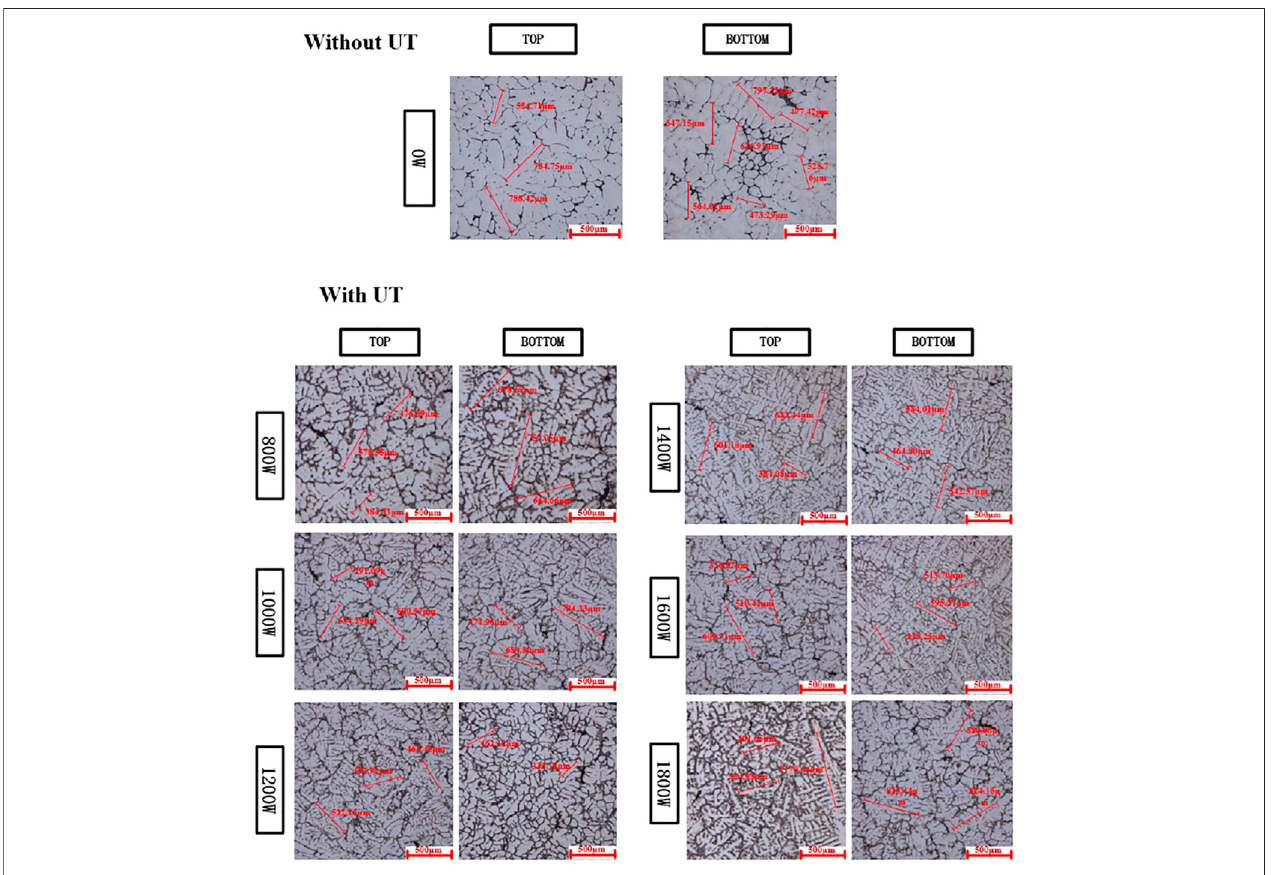
FIGURE 3 | Ultrasonic processing of optical micrographs of the top and bottom parts of 2195.